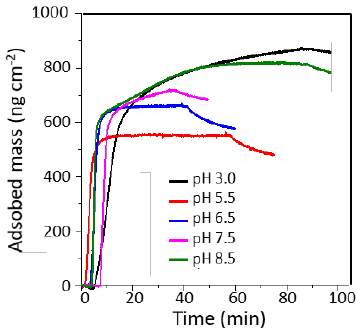
Figure 1. Adsorption of β-casein on lignin thin film at different pH observed using QCM-D.